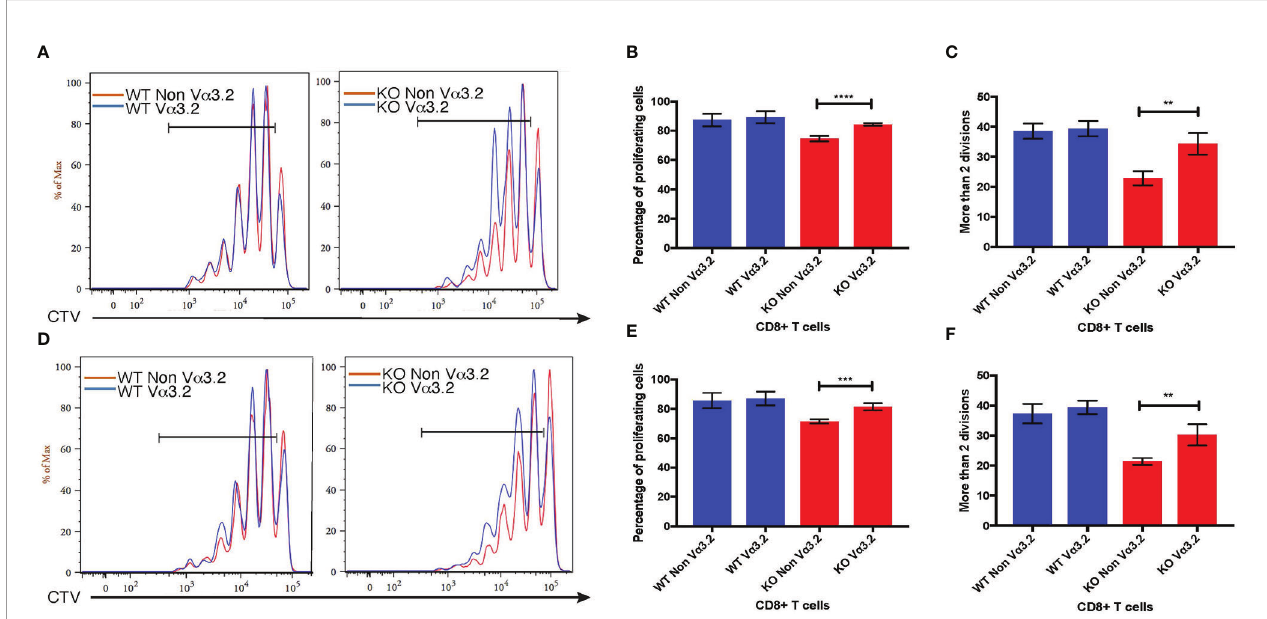
FIGURE 6 | Proliferative responses of V a 3.2 + CD8 + T cells in lymphopenic hosts. Proliferation of V a 3.2 + and non-V a 3.2 + naïve CD8 + T cells from Themis – / – and Themis +/+ mice in (A) lymph nodes and (D) spleen of sublethally irradiated CD45.1hosts. Histogram summary of the proliferation responses in (B) lymph nodes and (E) spleen of sublethally irradiated CD45.1 hosts. Proportion of V a 3.2 + and non-V a 3.2 + CD8 + T cells from Themis – / – and Themis +/+ mice that had more than two divisions in (C) lymph nodes and (F) spleen of sublethally irradiated CD45.1 hosts. Data are representative from three independent experiments with 4-5 biological replicates per genotype per experiment. ns not signi fi cant, **p < 0.01, ***p < 0.001, ****p < 0.0001 as determined by two-sided Student ’ s t-test. All error bars represent